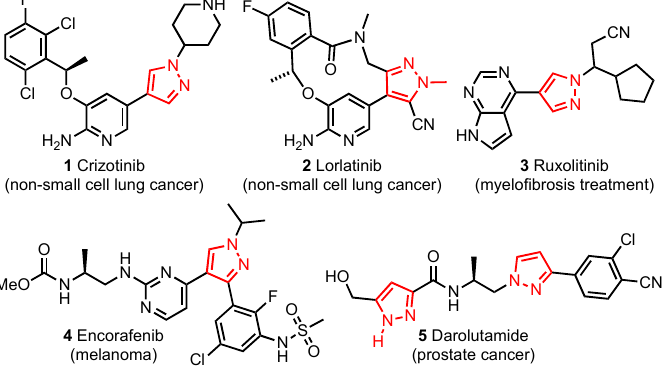
Figure 1. Examples of Anti-Tumor N -Alkyl Pyrazoles.